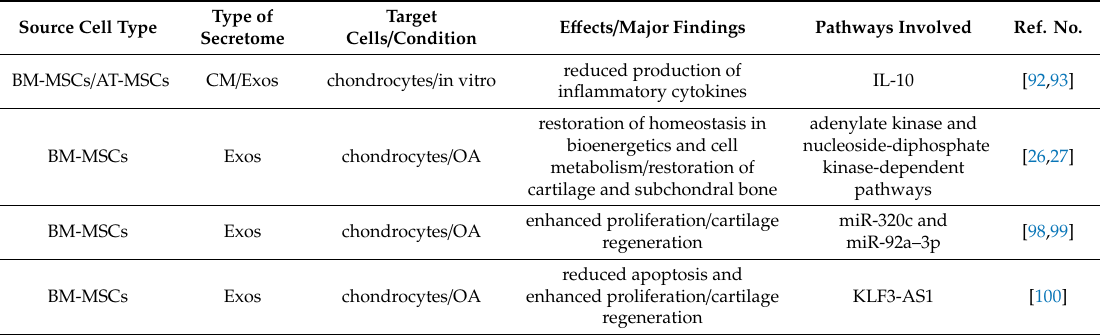
Table 3. Therapeutic potential of MSC-derived secretome in cartilage